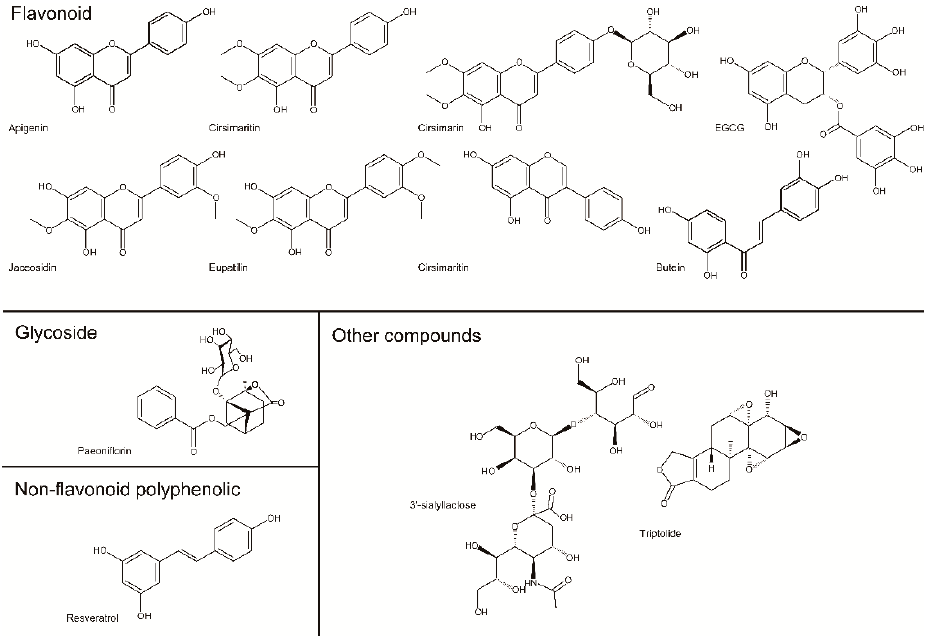
Figure 1. Structures of single compounds.